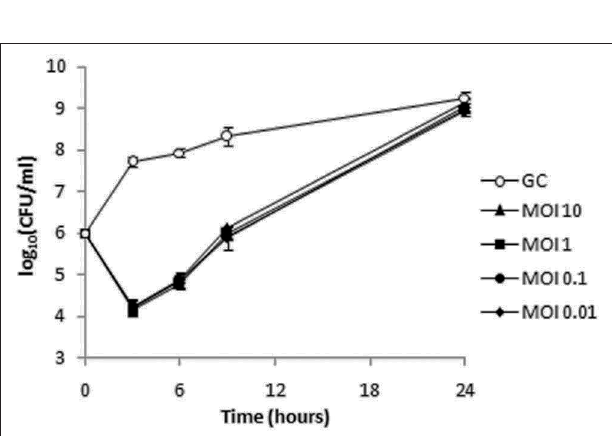
FIGURE 8 | Bacterial cell counts after treatment of planktonic culture of A. baumannii 6077/12 with bacteriophage ISTD. A reduction of 3.5 log units in CFU number compared to the untreated control was observed 3h after treatment. After 24h, no difference in the CFU counts between the infected cultures and growth control was observed. All MOIs applied had the same effect. GC, growth control without phages.